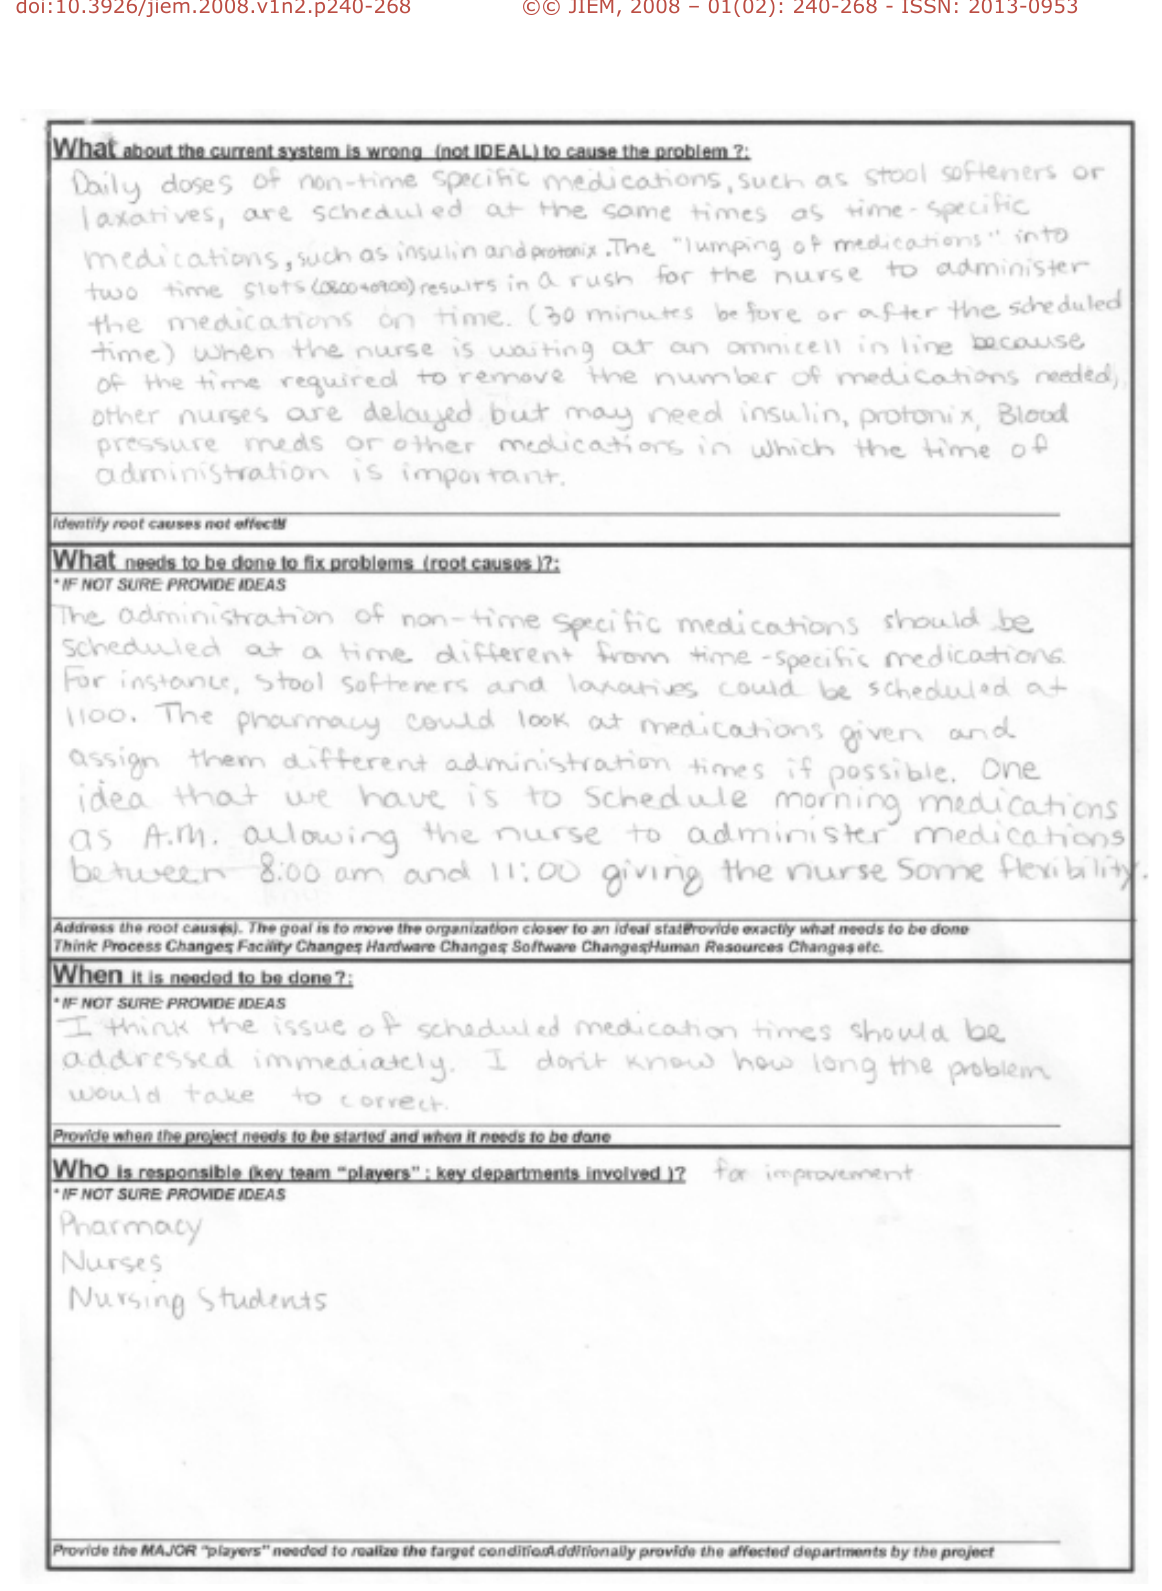
Figure 3b. “Example of Completed Map to Improve